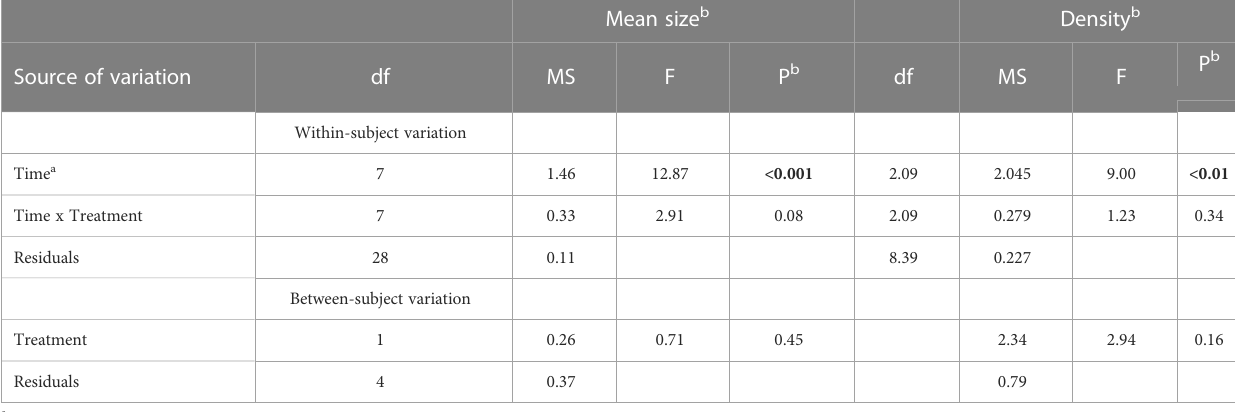
TABLE 3 Results of a repeated-measured analysis of variance (RM-ANOVA) on the mean size and density of adults (>3 cm) of the monitored transects in the receiving population (La L ı ́ nea).